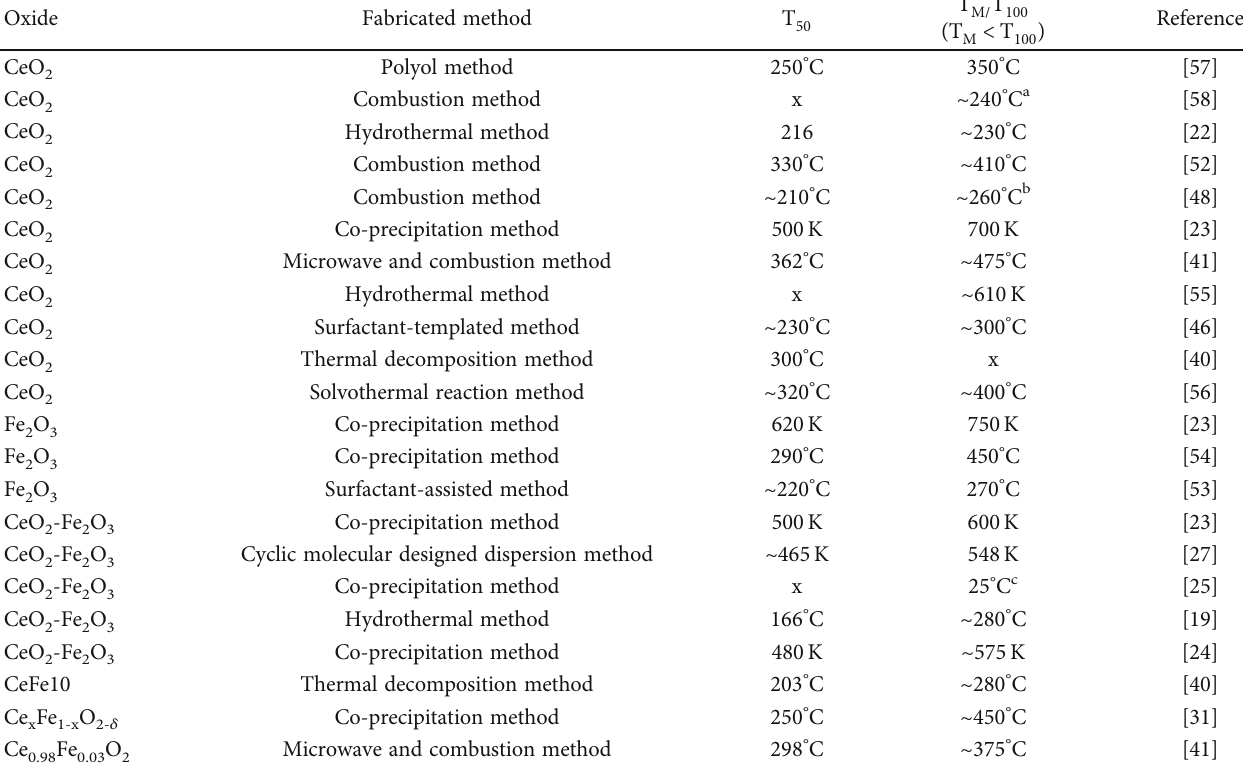
T Table 4: T 50 and 100 temperatures of CeO 2 , Fe 2 O 3 , and CeO 2 -Fe 2 O 3 oxides cited in some other references.